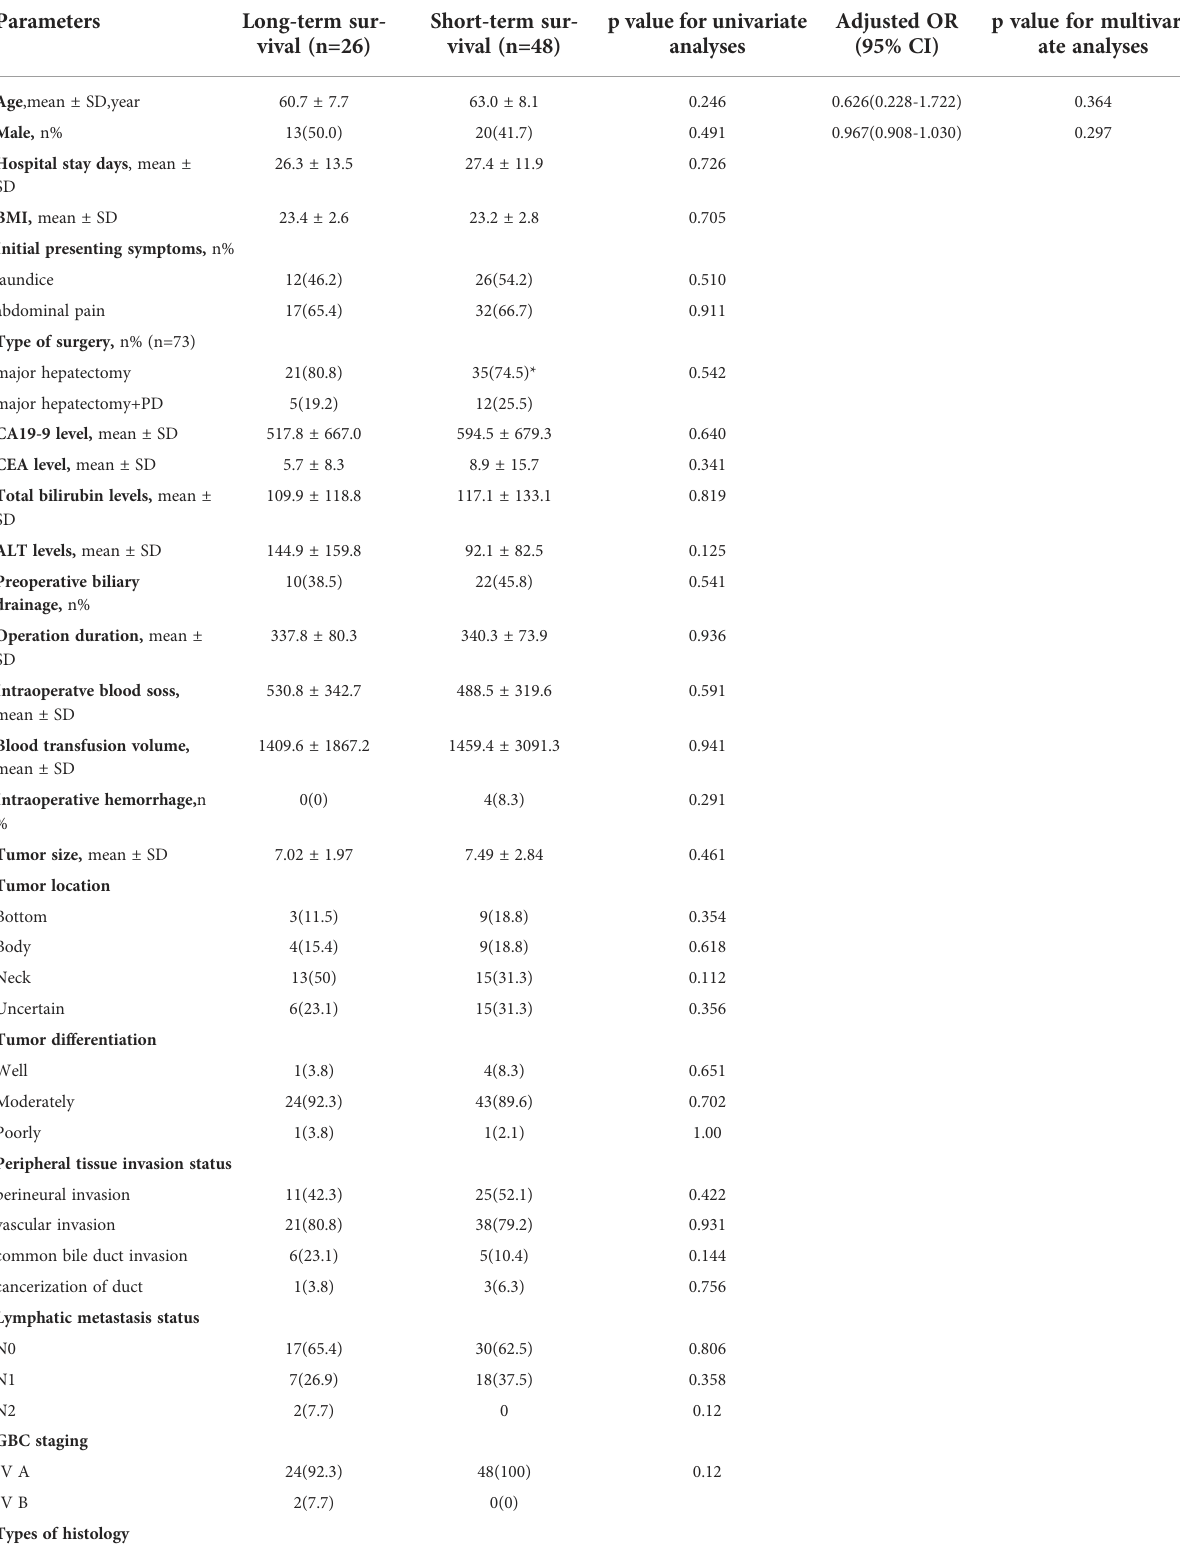
TABLE 4 Univariate and multivariable analyses of risk factors for long-term